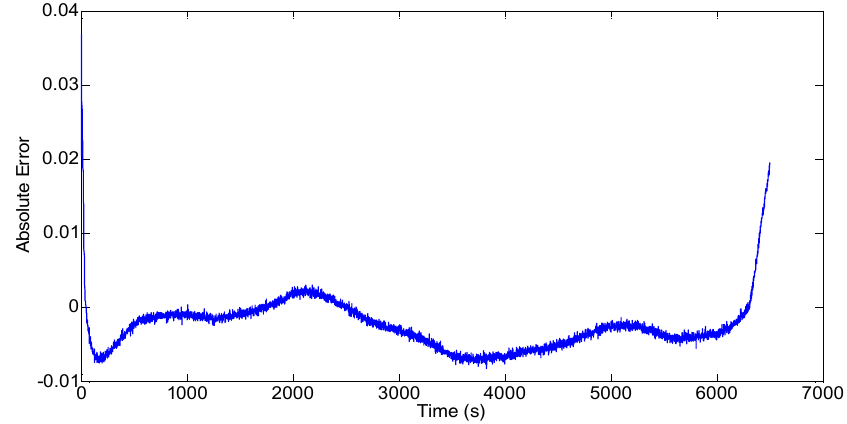
Figure 6. Model voltage and measurement voltage during a constant current test.